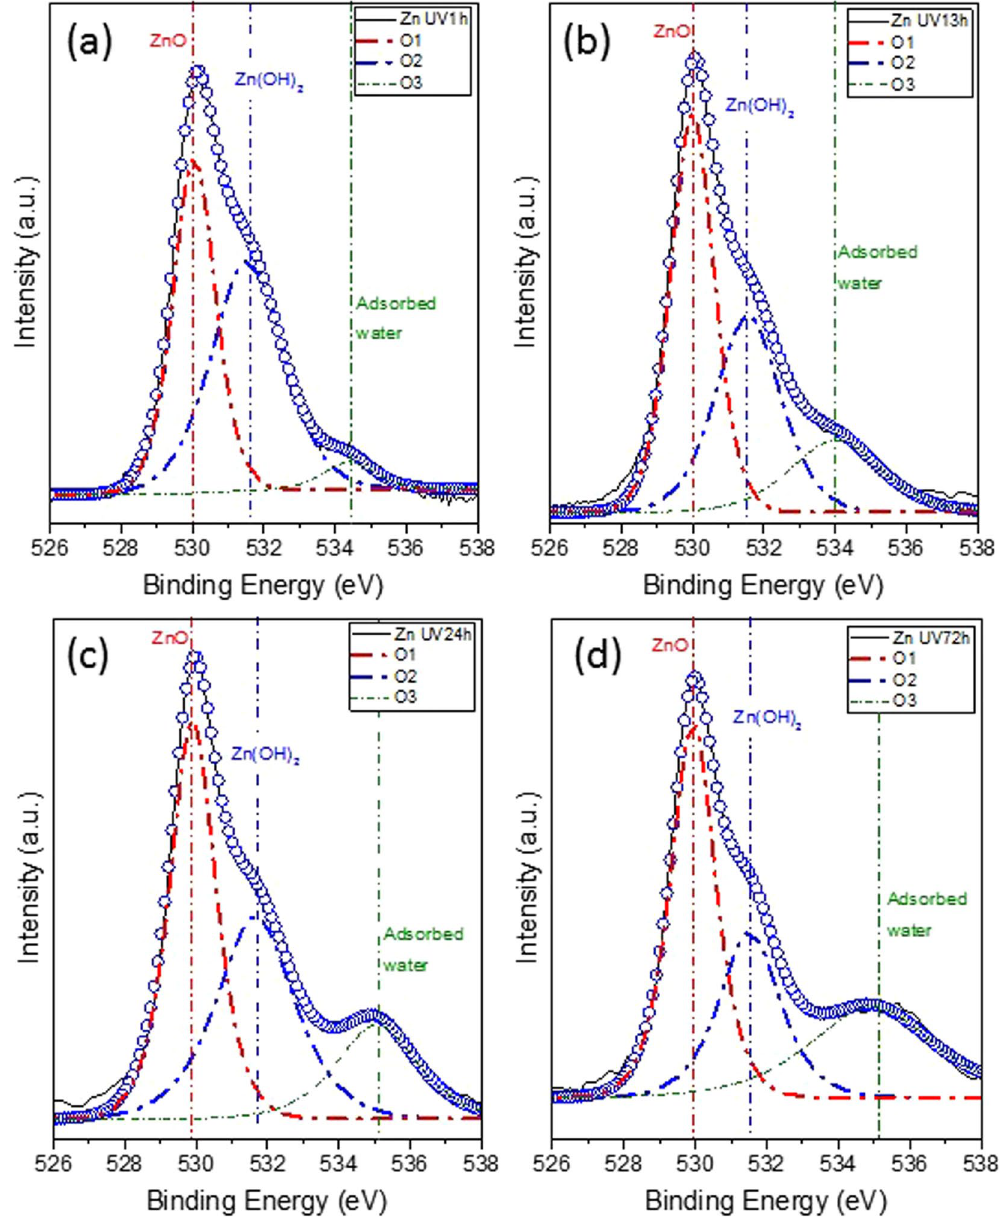
Figure 3. XPS spectra of the O 1 s peak of the Zn specimens after UV irradiation for different times: ( a ) 1 h, ( b ) 13 h, ( c ) 24 h, and ( d ) 72